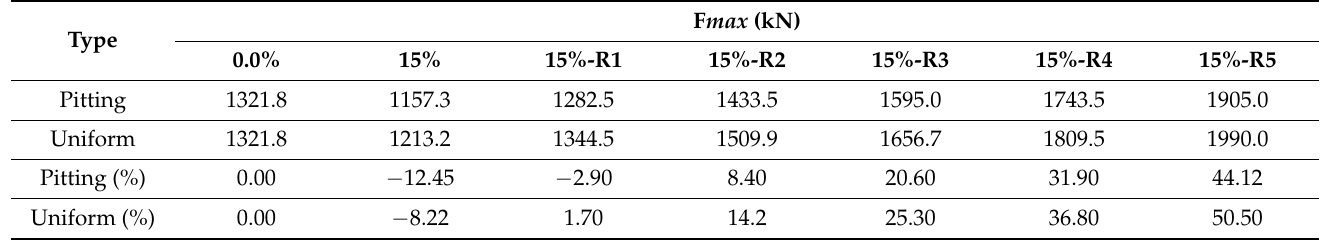
Table 4. Peak force of a bridge pier with 15% corrosion under different thicknesses of steel plates.